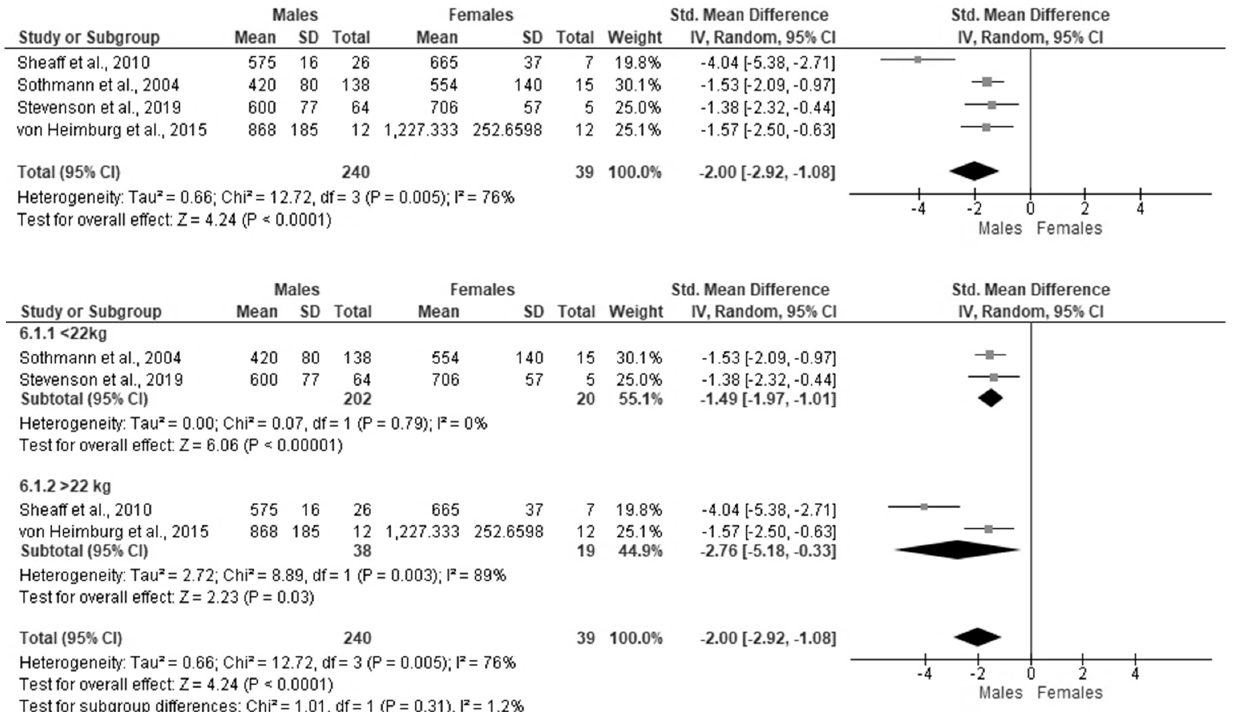
Figure 2. The effect of age and obesity on occupational performance in firefighters [39,57,70,74,77,79].